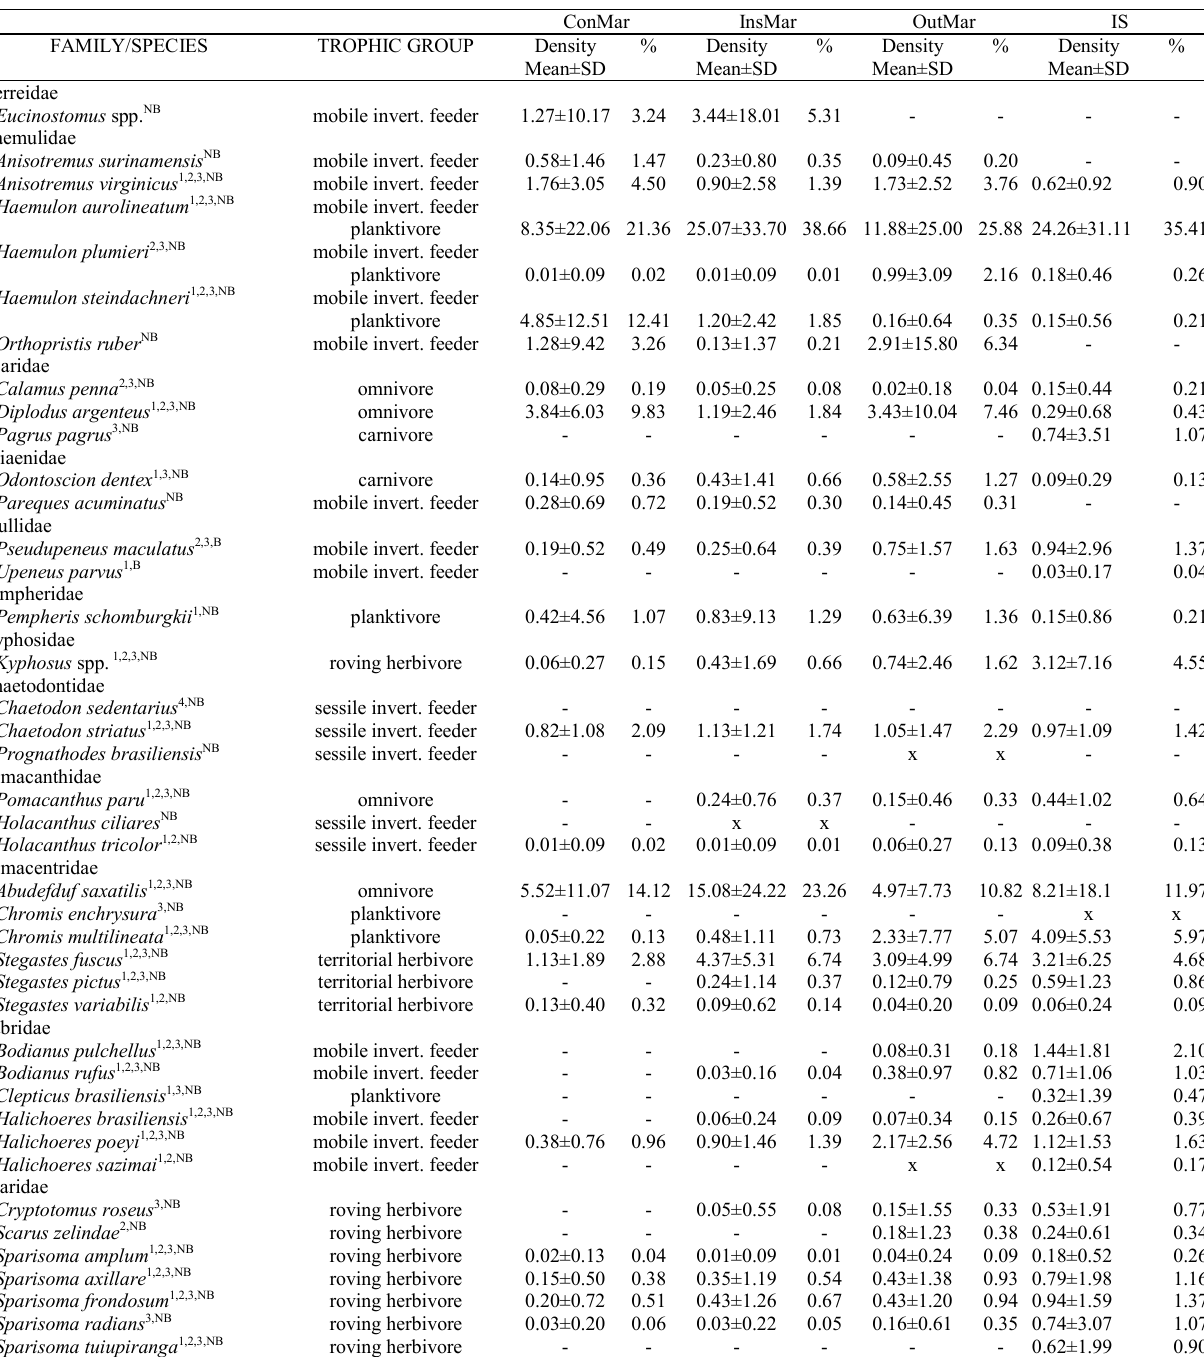
Table 1. (cont.) Rocky shore fish fauna recorded in the study region and quantitative summary for each stratum. ConMar = Continental Margin of the São Sebastião Channel; InsMar = Insular Margin of the São Sebastião Channel; OutMar = Outer Margin of São Sebastião Island; IS = islands (Alcatrazes, Búzios and Vitória). Systematic order follows Nelson (2006), Craig & Hastings (2007) and Smith & Craig (2007). Species in bold type were not observed during the censuses. Trophic groups based in data from underwater observations and stomach content analysis in Gibran & Castro (1999), Gibran (2007) and Pires & Gibran (2011), and additional literature (Randall, 1996; Carvalho-Filho, 1999; Santos, 2005) - but see Ferreira et al. . (2004) for categories’ details. Species observed only during the collecting activities, photo or video records are marked with an “x” (presence) or “-” (absence). Species recorded for each of the three islands or at another locality inside the study area are discriminated with superscripts (Alcatrazes 1 , Búzios 2 , Vitória 3 , Farol dos Moleques 4 , and Channel buoys 5 - see Fig. 1 for a map). Species are also discriminated with superscripts by their positions in the water column: benthic B or nektobenthic NB